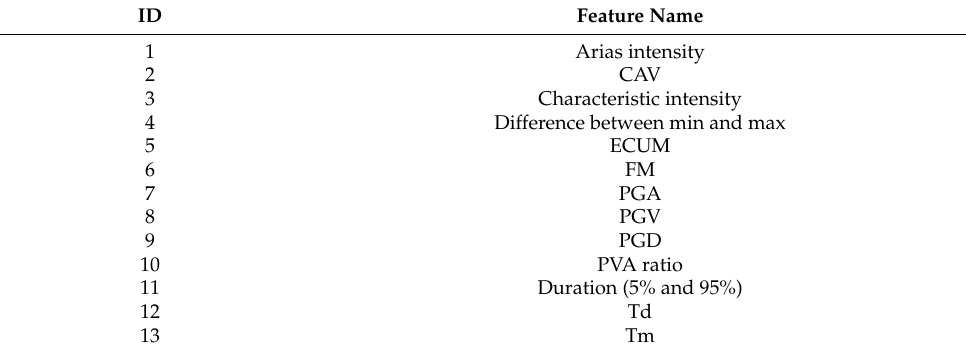
Table 2. Seismic wave features used in the study.